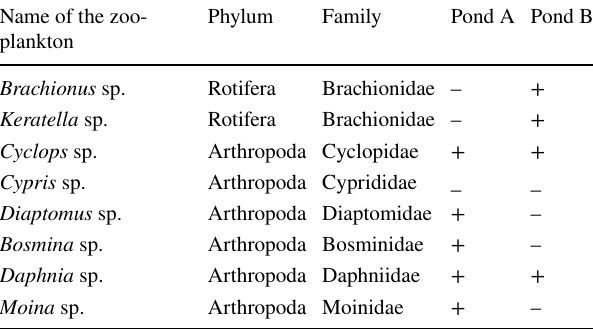
Table 3 Variations in zooplankton specimens of two urban ponds (A and B) of Chandannagar recorded during the study period (Nov–Dec, 2017) of the zoo- plankton